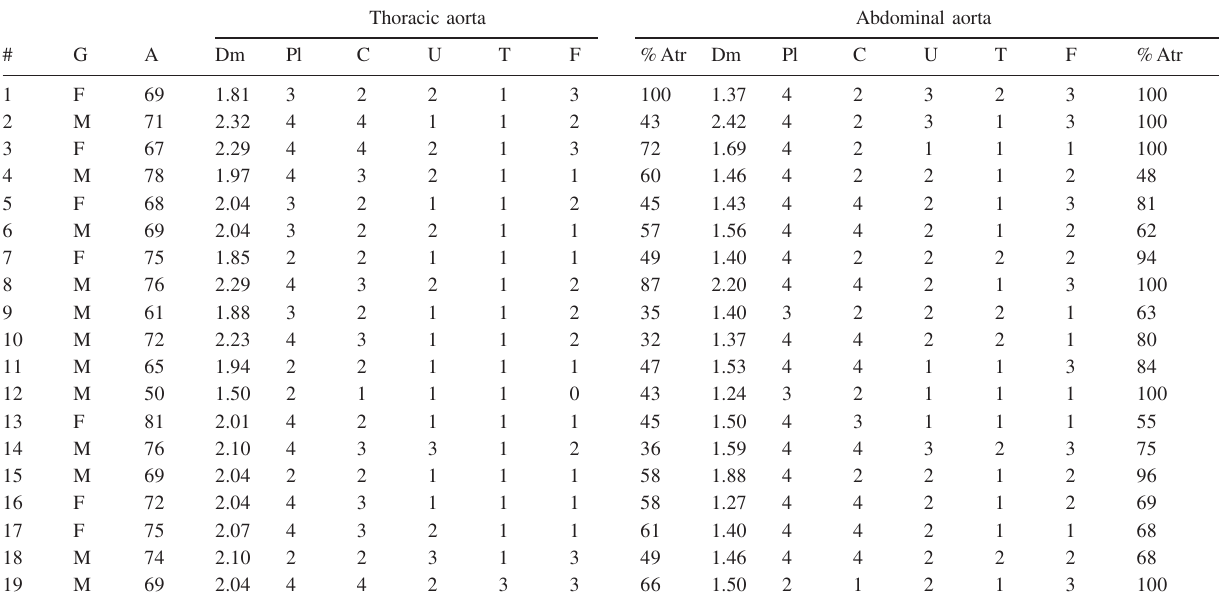
Table 1 - Gender, age, aortic diameter, semiquantitative scores, and percentage of medial layer atrophy of the thoracic and abdominal segments of the